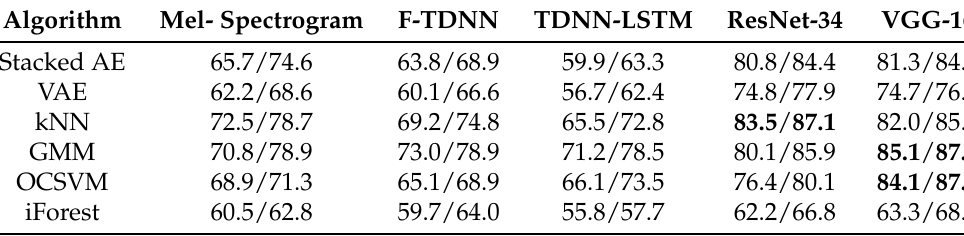
Table 3. The Average F1/AUC Scores of AND on US8K dataset.